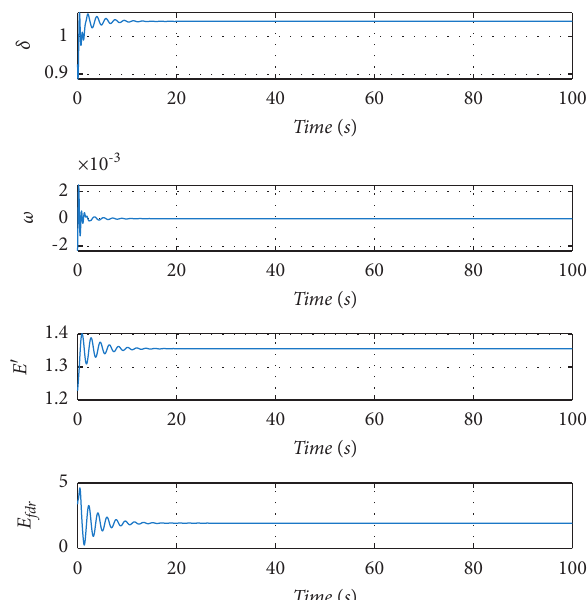
Figure 12: Time series responses for controlled fractional-order power system (31) with control in action at t � 0 ( s )